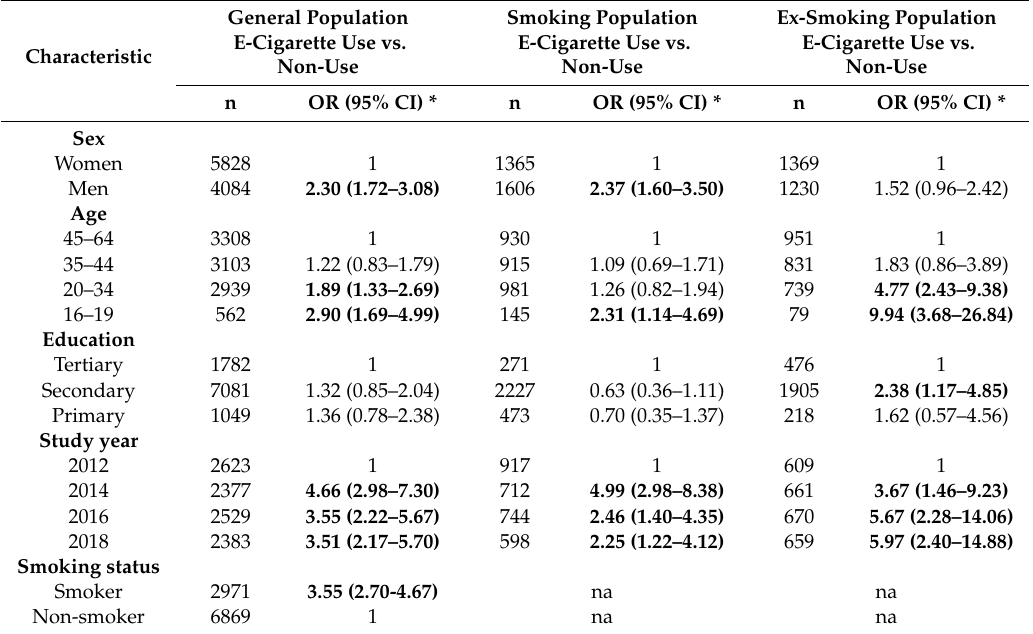
Non-smoker na * Statistically significant ( p < 0.05) associations are given in